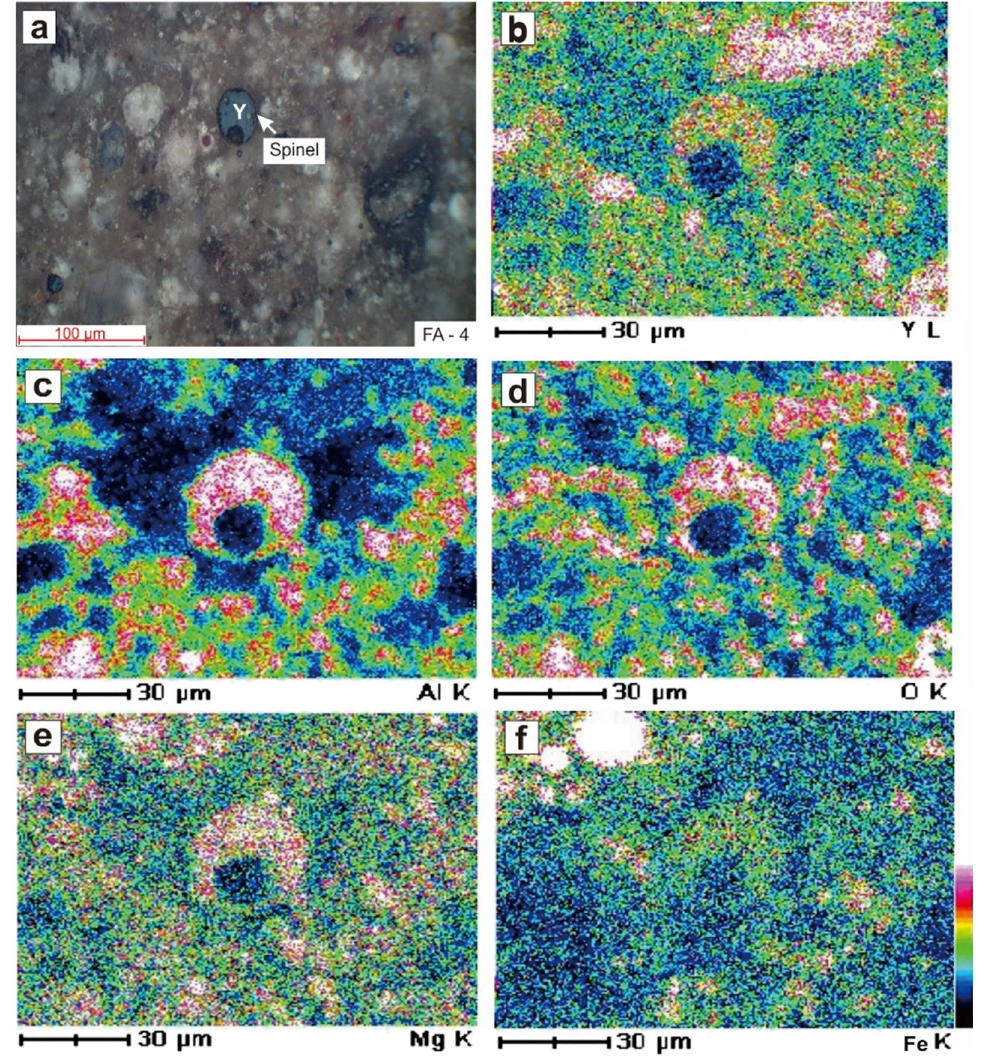
Fig. 15 Mode of occurrence of Y in spinel (sample FA-4). a Optical microscopy reflected of white light; elemental mapping shows the distribu- tion of Y along with the region rich in Al and O, Mg and